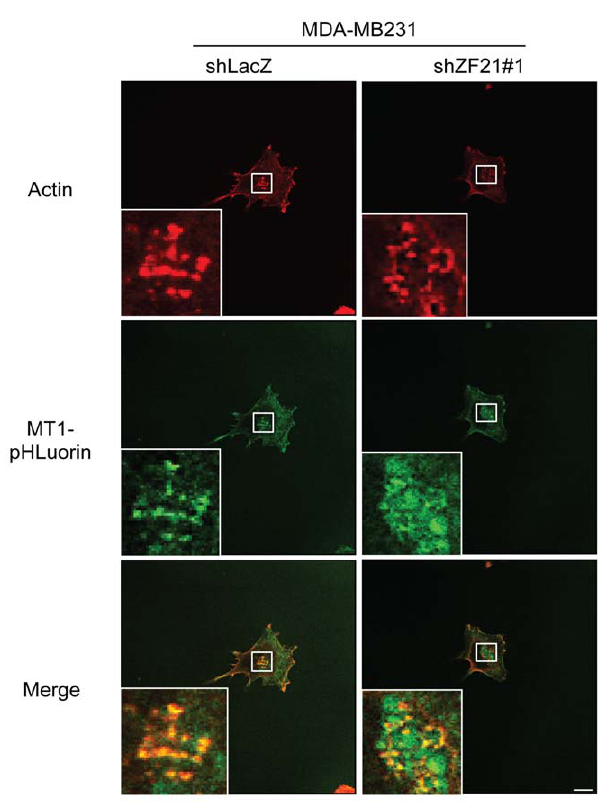
Figure 5. ZF21 regulates localization of MT1-MMP to invado- podia. MT1-MMP-pHLuorin (MT1-pHLuorin) was transiently expressed in the MDA-MB231 cells expressing either shLacZ or shZF21 # 1. The cells were cultured on cover slips coated with 50 m g/ml fibronectin for 6 hours. After fixation, the cells were stained with Rhodamine-labeled phalloidin to visualize F-actin. The localizations of F-actin (red on top panels) or MT1-MMP-pHLuorin (green on middle panels) were observed using confocal microscopy. The merged pictures of red and green fluorescence were shown on bottom panels. The boxed areas are shown at higher magnification in the panels. (scale bar, 10 m